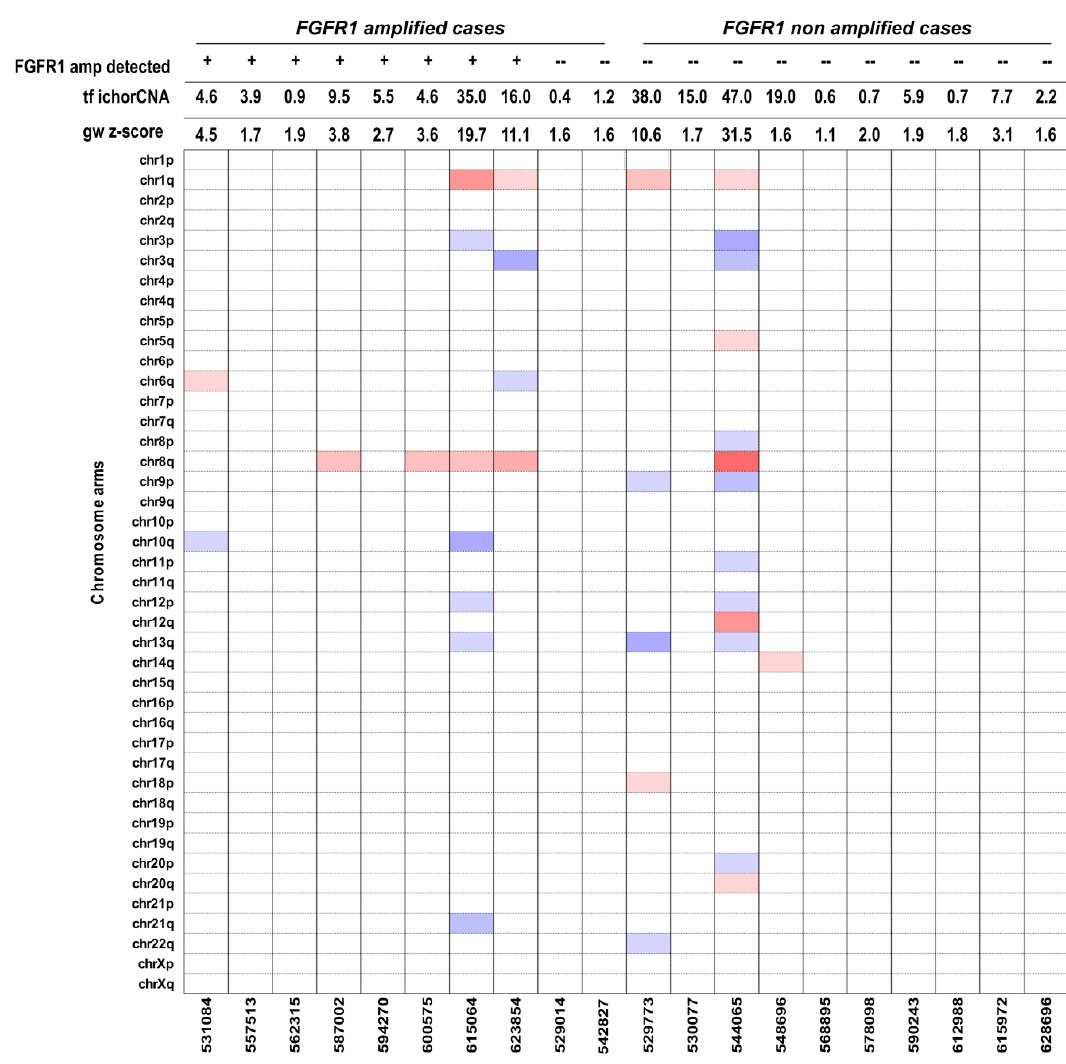
Figure 1. mFAST ‐ SeqS (modified fast aneuploidy screening test ‐ sequencing system) LINE ‐ 1 profiles for FGFR1 amplified ( n = 10) and non ‐ amplified cases ( n = 10). Heat ‐ map of selected plasma samples with different values of genome ‐ wide z ‐ scores. Blue bars indicate chromosome ‐ specific Z ‐ scores < 5, and red bars indicate chromosome ‐ specific z ‐ scores >5. Amongst the 20 samples analyzed with mFAST ‐ SeqS, the z ‐ score ranged from 1.1 to 31.5 with a median of 2.2m with only 4 samples showing a Z ‐ score > 5.